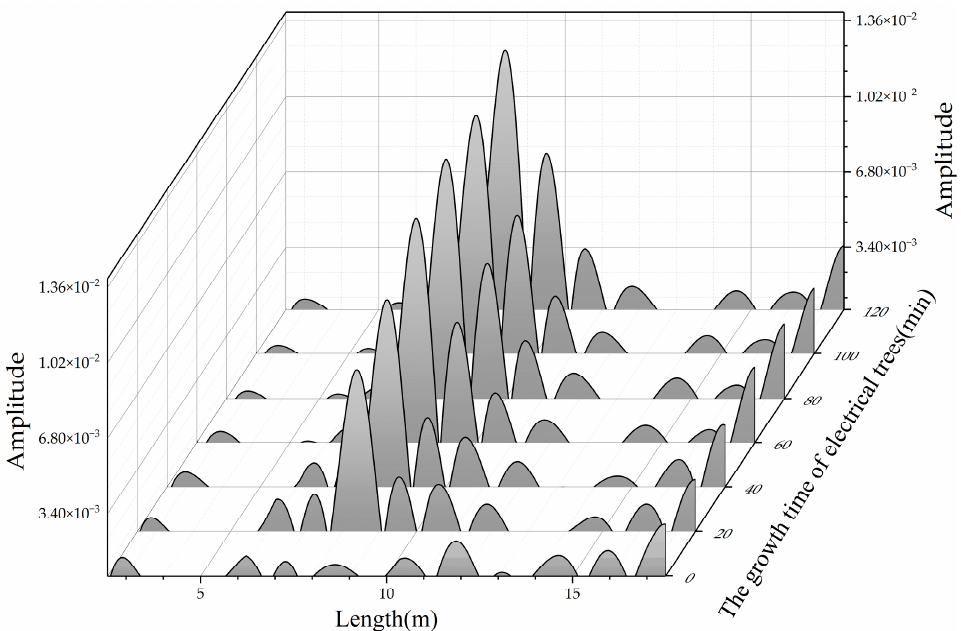
Figure 13. Location spectrum with bush-pine trees at 9.3 m.